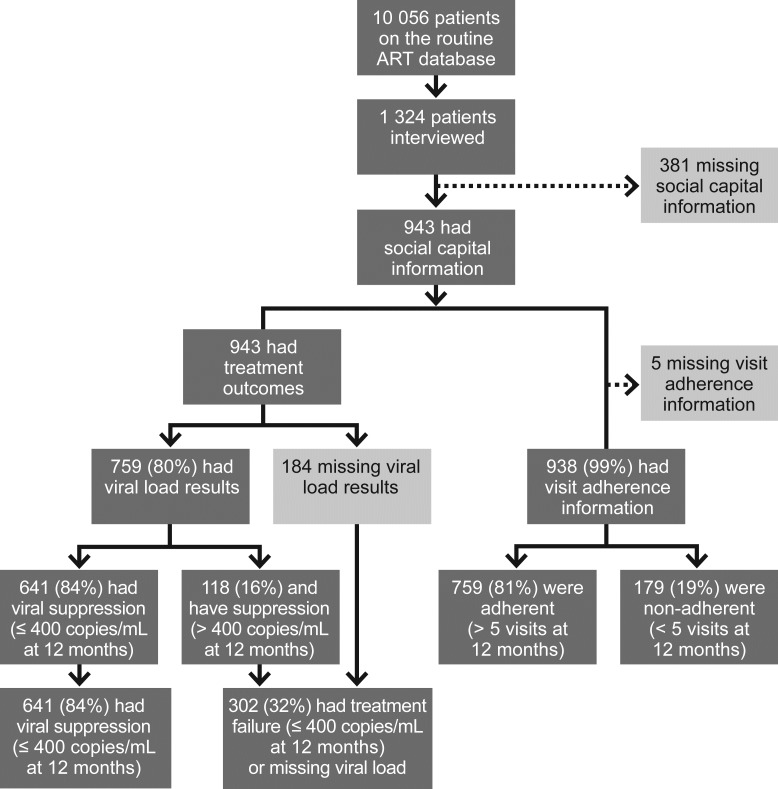
Number and proportions of participants in the study at various stages.